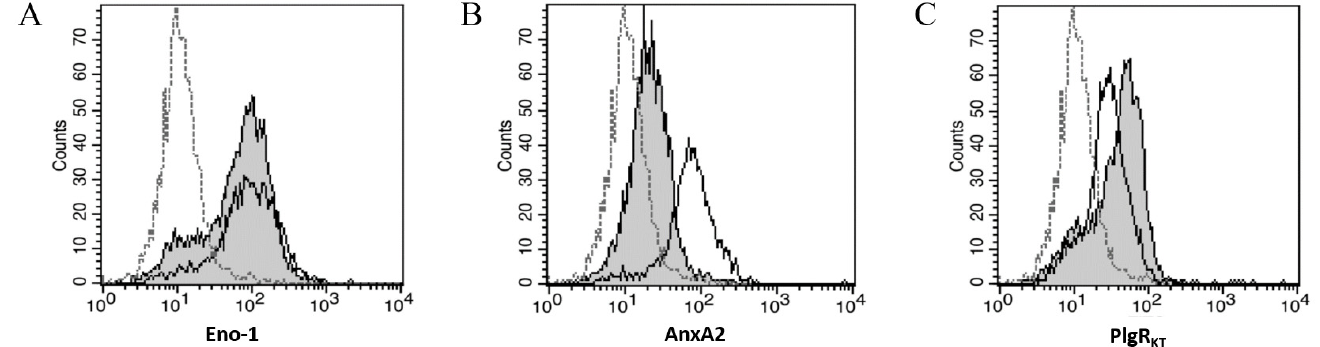
Figure 4. Three Plg-Rs are Detected on Mesothelial Cells; Plg-R KT Contributes to Plg Binding . Representative flow cytometric analyses showed significant expression of ( A ) ENO-1, ( B ) AnxA2, and ( C ) Plg-R KT on MeT5A (–––) and peritoneal mesothelial cell surfaces (grey shaded histogram). In all histograms, isotype control shows little binding (- - -).